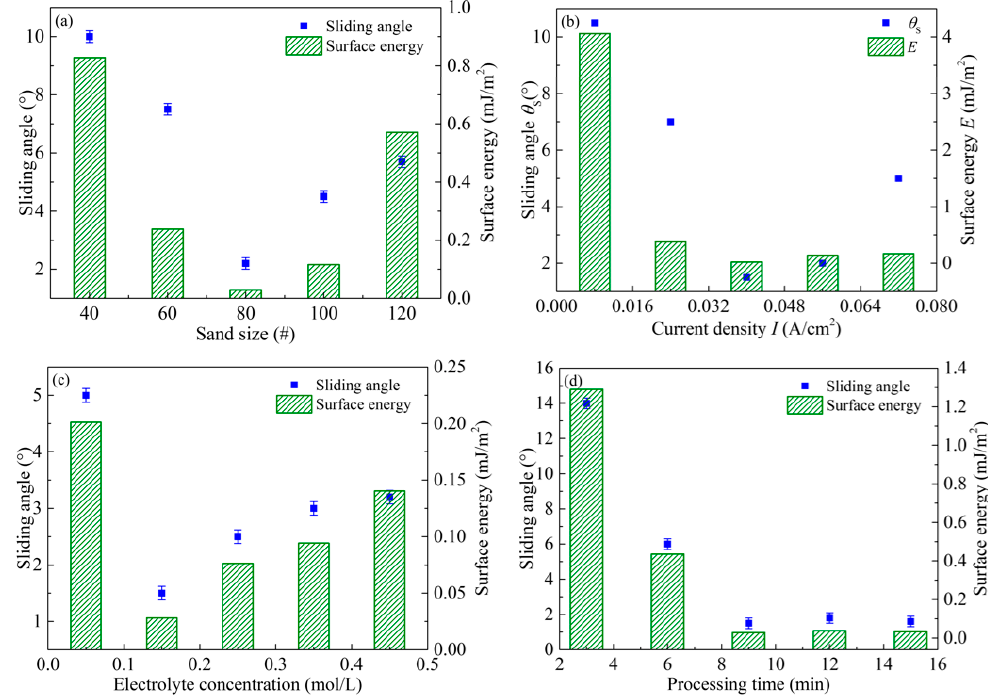
Figure 7. Influence of sand size ( a ), current density ( b ), electrolyte concentration ( c ) and processing time ( d ) on the sliding angle and the adhesive energy of the fabricated surface.